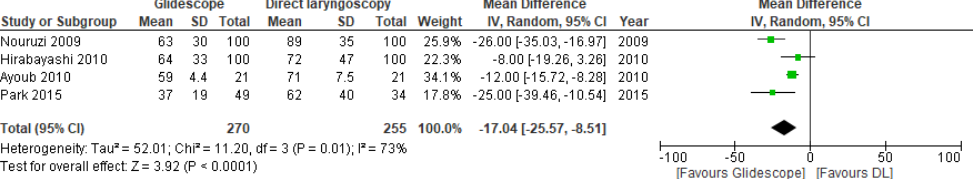
Figure 7. Mean difference (MD) in time to intubation (in seconds) in clinical trials comparing Glidescope ® videolaryngoscope to direct laryngoscopy. The pooled estimate (rhombus) was derived using the DerSimonian and Laird random effects method. The squares depict an individual study point estimate of the mean difference. Solid horizontal lines display the 95% CI of the point estimate. The vertical line represents an MD of o, indicating no difference between Glidescope ® videolaryn- goscopy and direct laryngoscopy. (DL = direct laryngoscopy). Nouruzi, 2009 [38]; Ayoub, 2010 [36]; Hirabayashi, 2010 [37]; Park, 2015 [39].